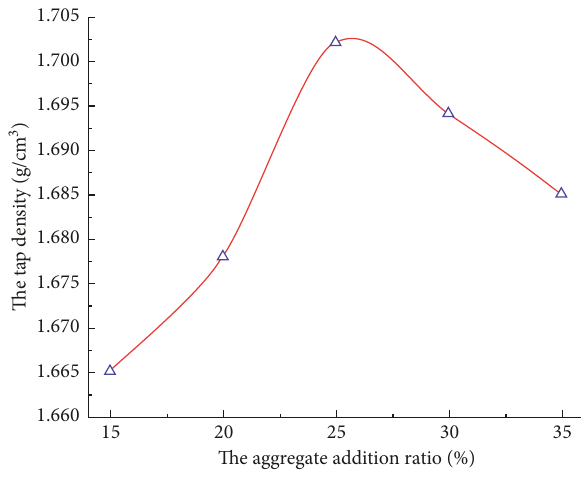
Figure 2: First filling